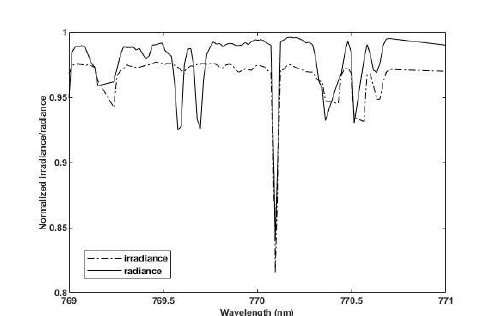
Figure 2. The normalized spectral curve of radiance spectrum and irradiance